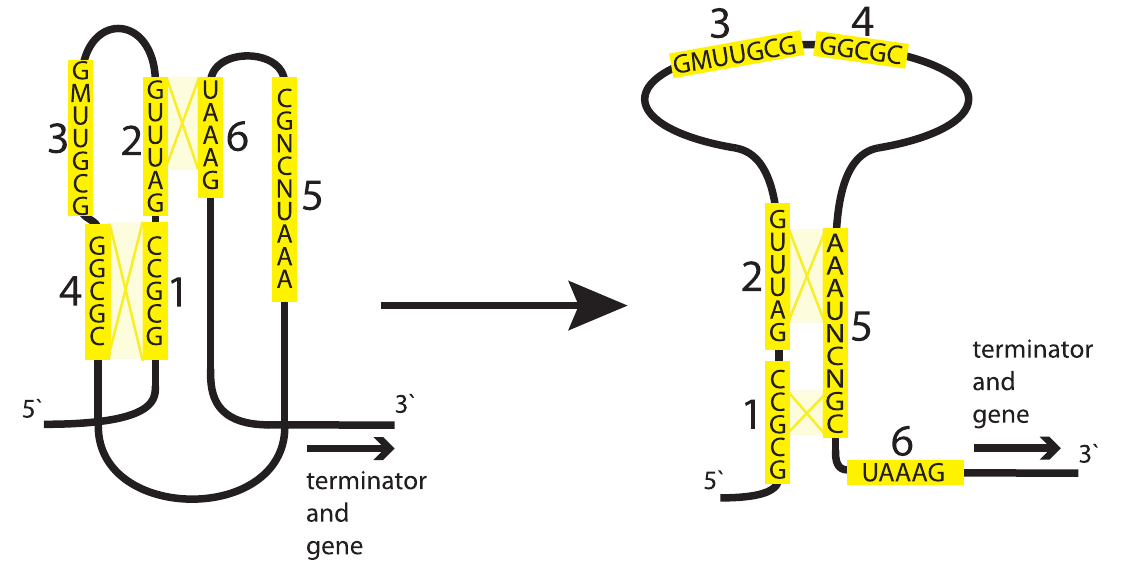
Figure 8. Alternative secondary structures of candidate metXZ RNA element. Regions 1–6 shown in yellow boxes are conserved sequences found in the multiple alignment of leader regions of 34 metX and metZ genes from b -proteobacteria (Figure S2). In the consensus RNA sequence, N denotes any nucleotide, and M stands for A or C. Possible secondary structures formed by the interaction between the conserved regions are shown by yellow lines.